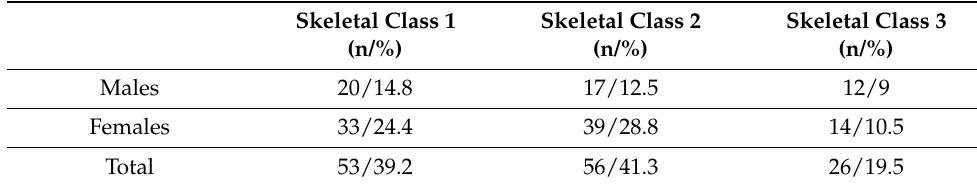
Table 2. Data of the skeletal sagittal classifications according to the gender of the individuals included in the study (n = 135).